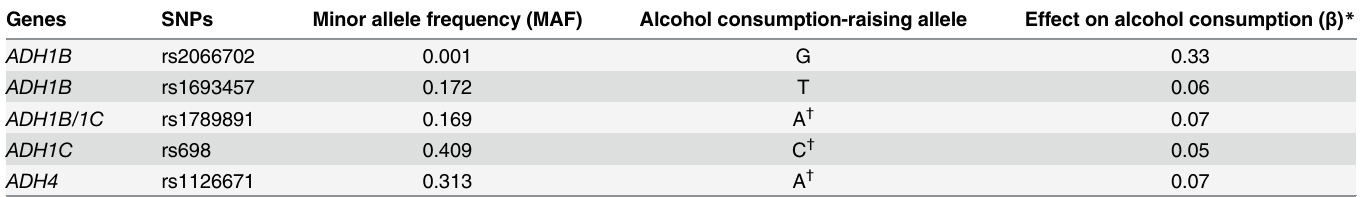
Table 3. Final instrumental